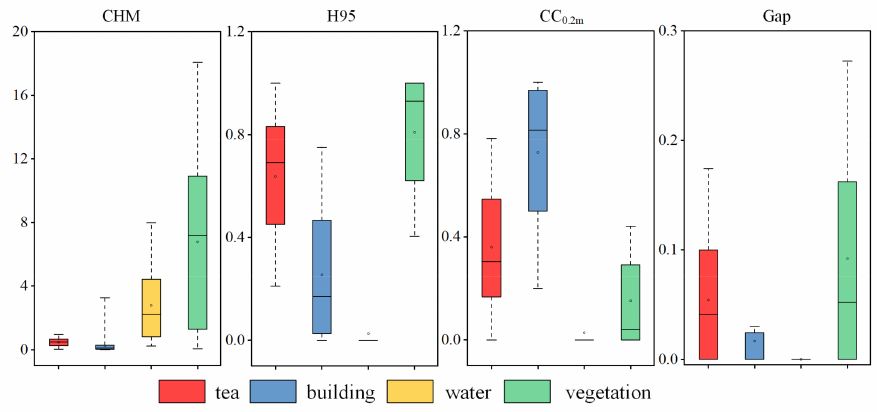
Figure 8. The difference among classes in UAV lidar metrics.